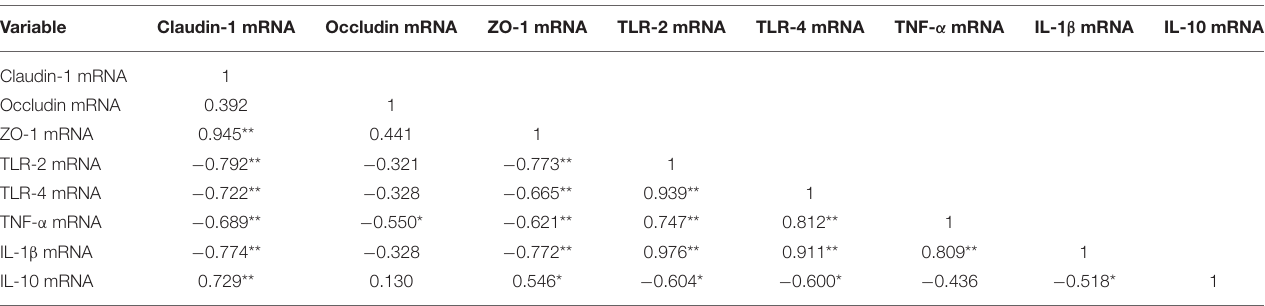
TABLE 5 | Correlation analysis of intestinal barrier and intestinal inflammation.